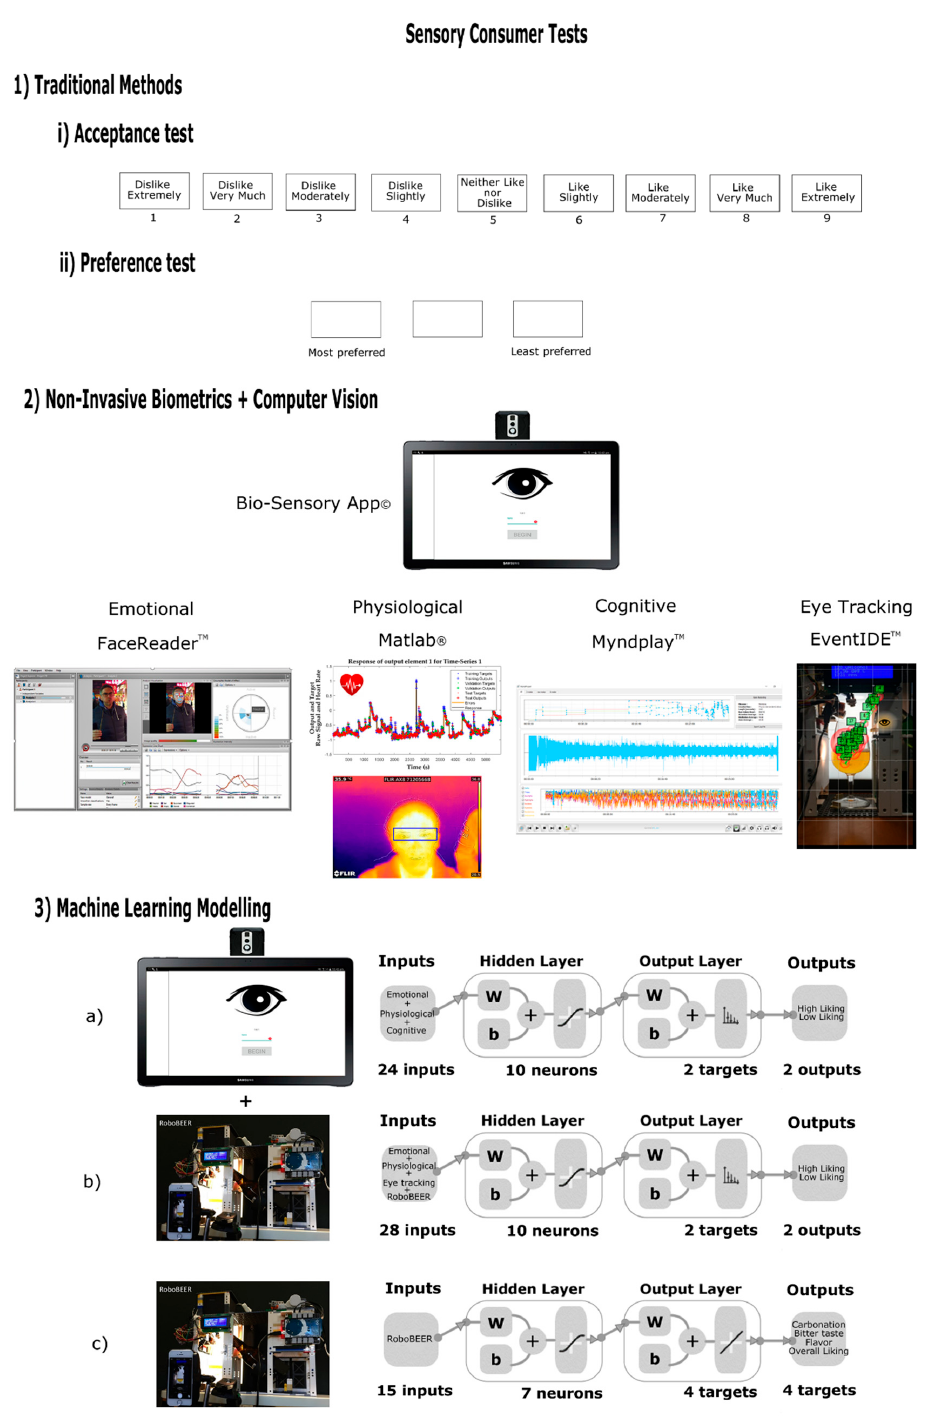
Figure 1. Representation of sensory acceptability methods to assess carbonated beverages, including the traditional and more advanced techniques including non-invasive biometrics, robotics, and machine learning techniques. Showing the model diagrams to assess ( a ) low and high levels of liking of carbonation mouthfeel, flavor and overall liking using biometrics as inputs, ( b ) low and high levels of liking of foam using biometrics and color and foam-related parameters as inputs, and ( c ) rating of carbonation mouthfeel, bitter taste, flavor and overall liking using color and foam-related parameters as